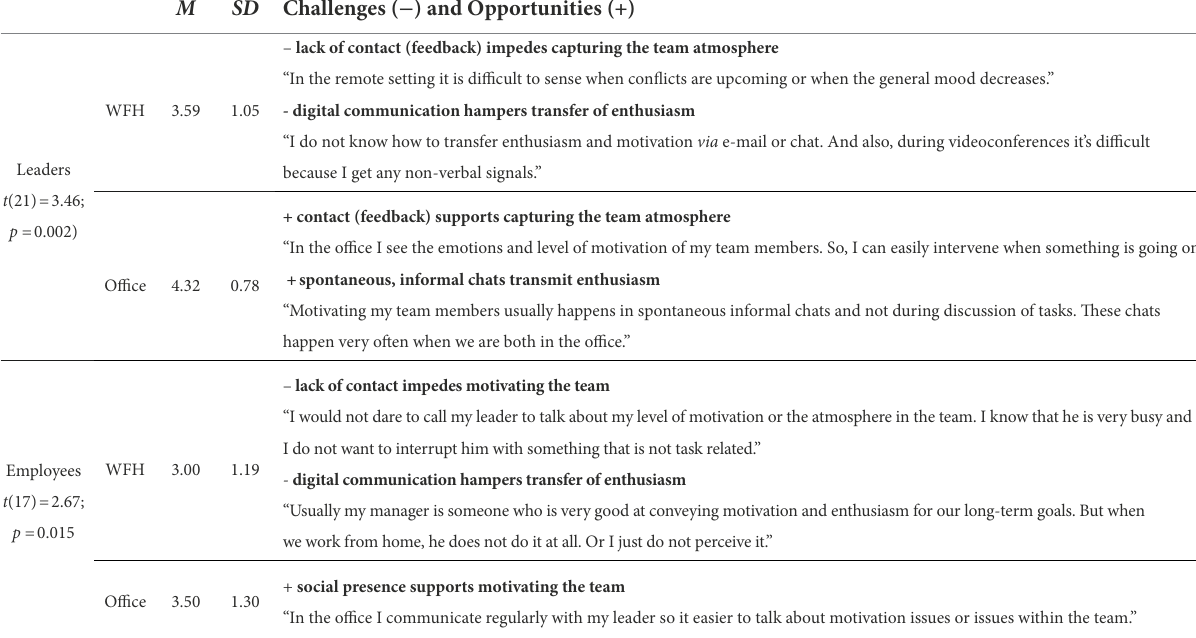
TABLE 2 Challenges and opportunities for inspirational